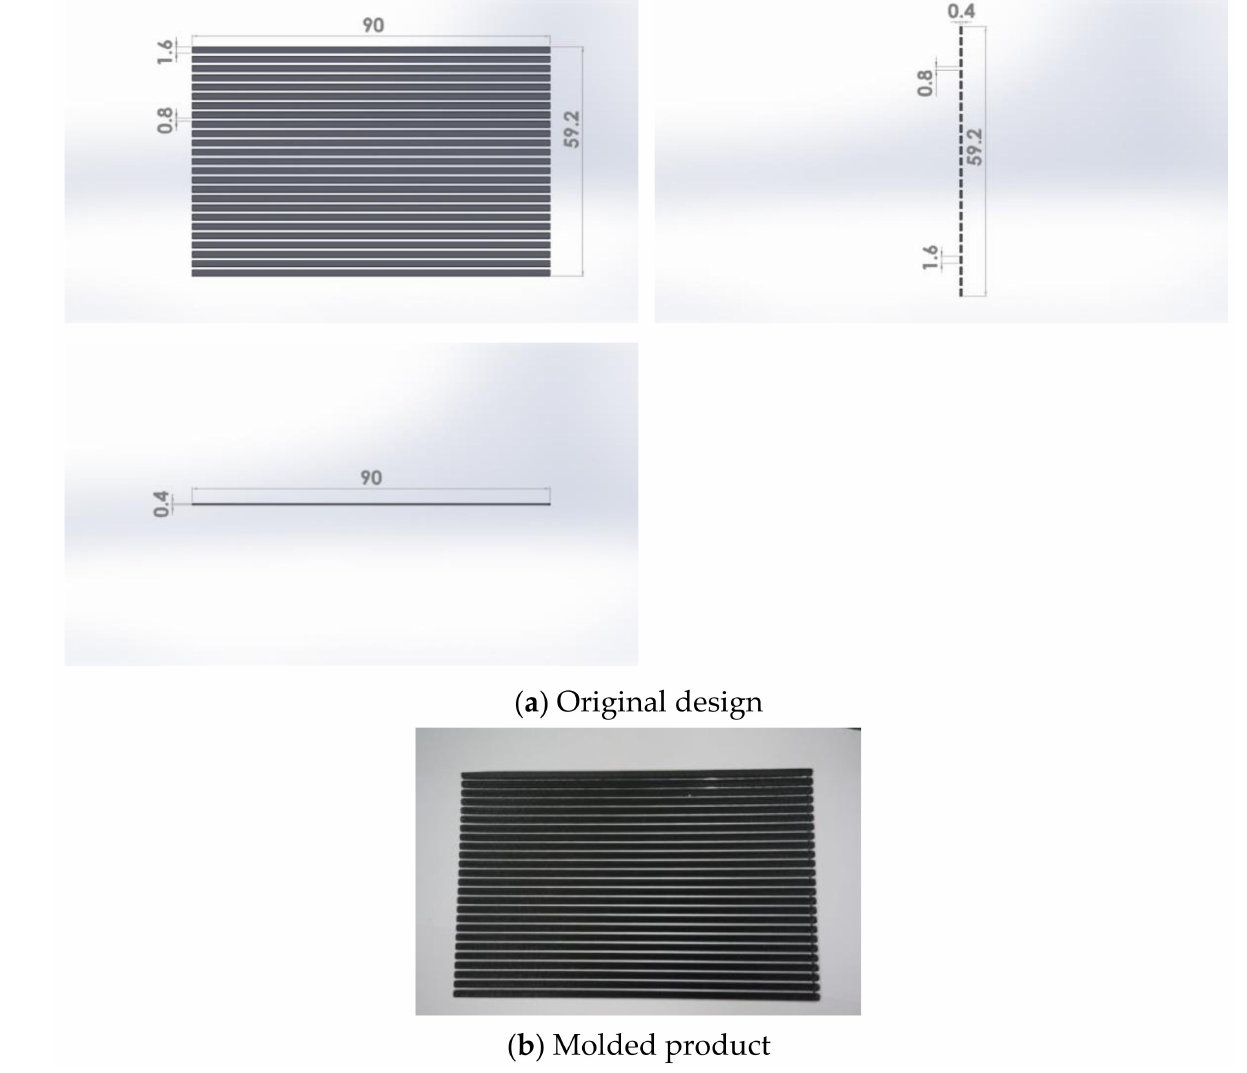
Figure 2. Stimulus-responsive composite material (polylactic